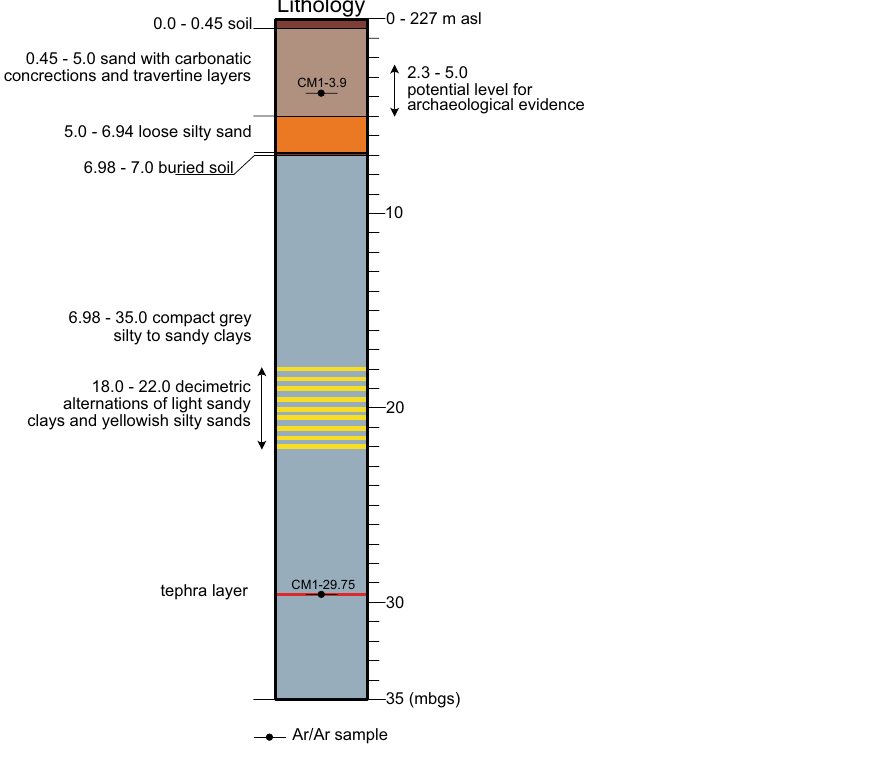
Figure 3. Simplified stratigraphic log of the Colle Marino borehole (CM1). For detailed lithological description and sampling, see Figure S2 in Supplementary Material